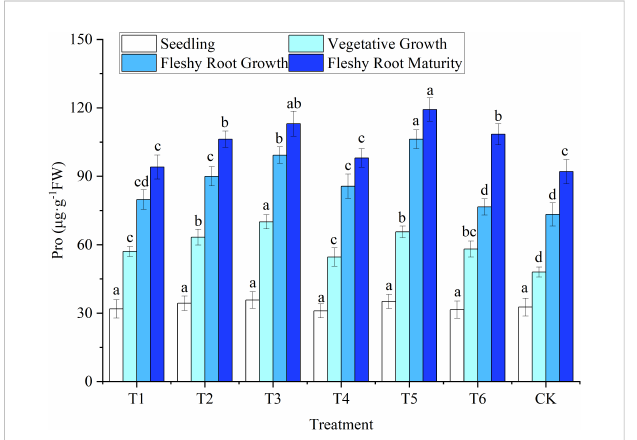
FIGURE 6 The response of peroxidase (POD) activity in woad plants in different water de fi cits. Different lowercase letters in the same column mean the signi fi cant differences among treatments according to LSD ( P < 0.05). Data were presented as mean ± SE (n = 3).